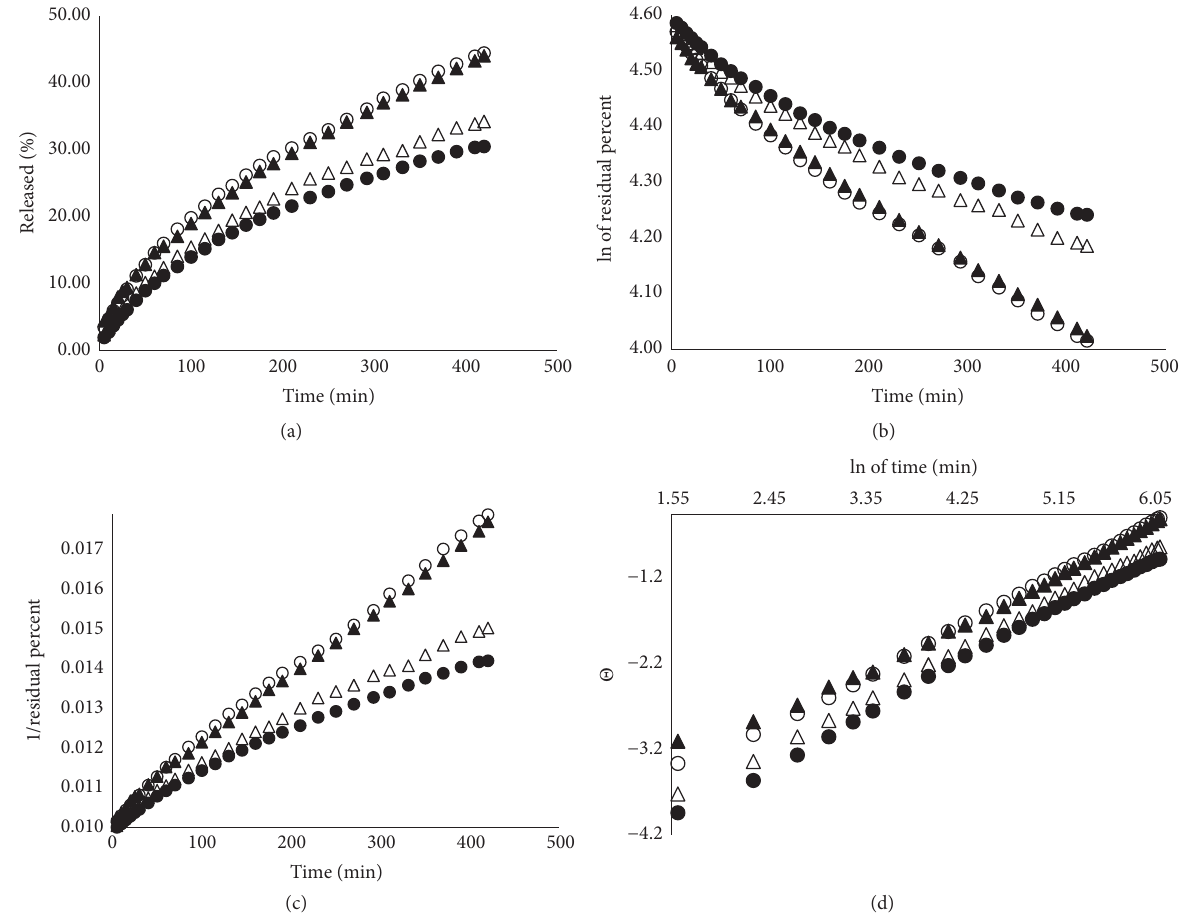
Figure 3: Presentation of release kinetics of EH from various hydrophilic gels according to specified release models. (a) Zero-order kinetics, (b) first-order kinetics, (c) second-order kinetics, and (d) Weibull model. I , MC; △ , PA1; e , PC-11; 󳵳 , reference gel, PA2; 𝑛 = 6 ; Θ , ln [ − ln(1 − (released percent/100%))].